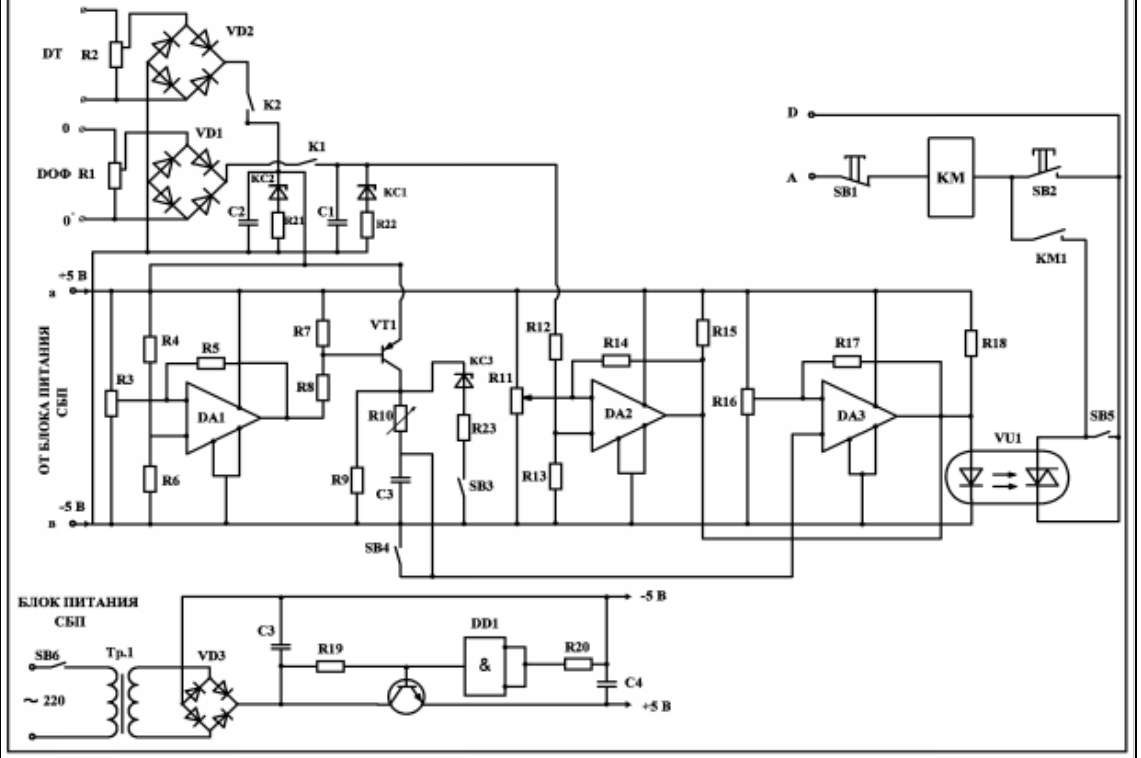
Figure 2. The electrical circuit scheme of the protection